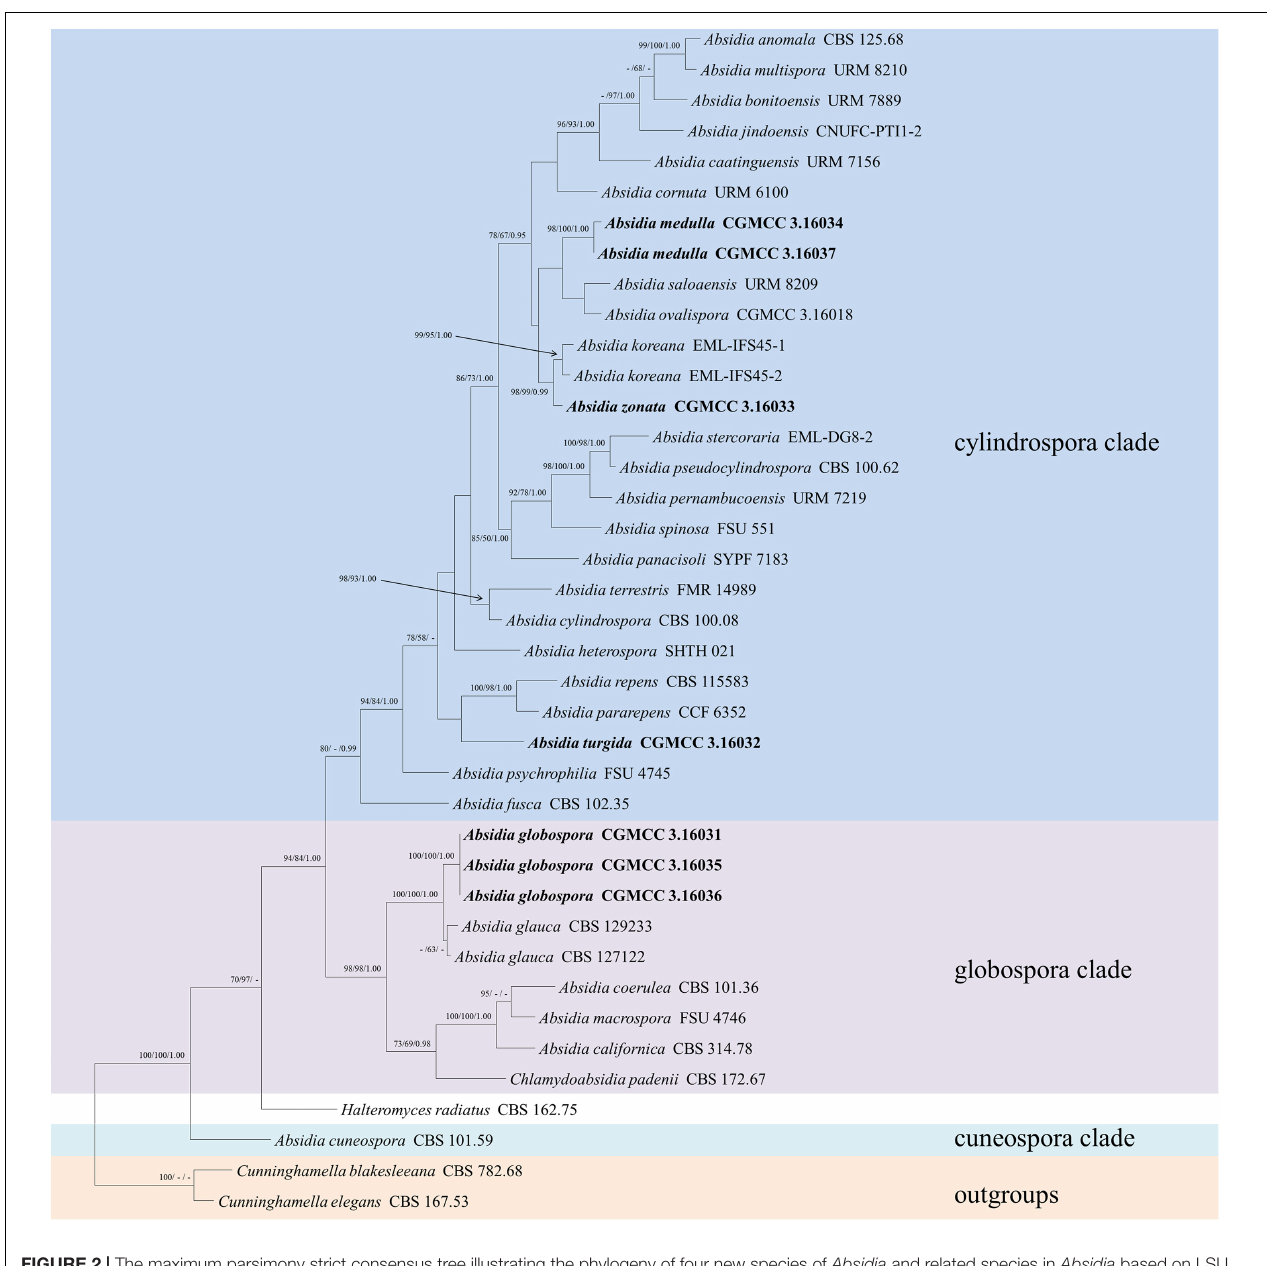
FIGURE 2 | The maximum parsimony strict consensus tree illustrating the phylogeny of four new species of Absidia and related species in Absidia based on LSU sequences. Cunninghamella elegans and Cunninghamella blakesleeana serve as outgroups. Branches are labeled with maximum likelihood bootstrap values higher than 70%, maximum parsimony bootstrap values higher than 50%, and Bayesian posterior probabilities more than 0.95. The lower left scale represents